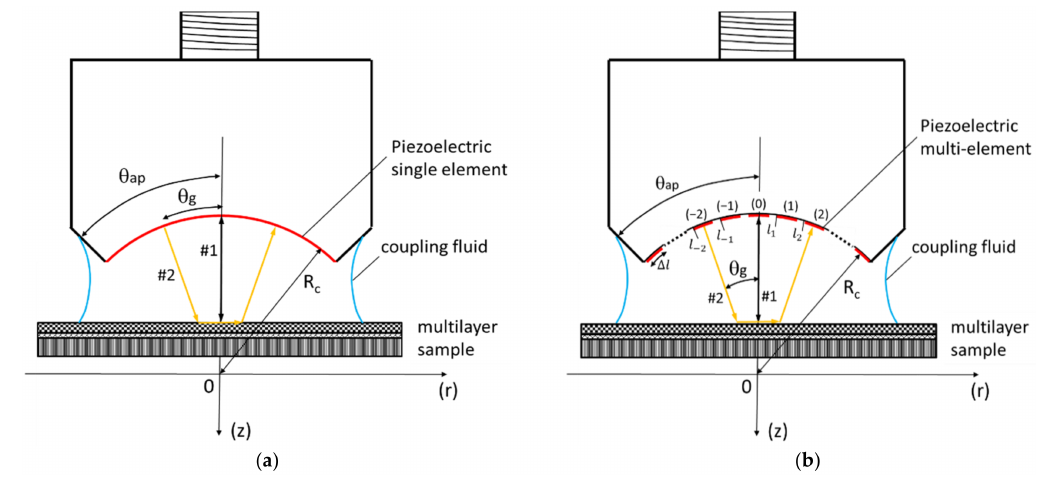
Figure 1. ( a ) Principle of interference with a classical V ( z ) transducer; ( b ) corresponding scheme with a segmented V ( z )